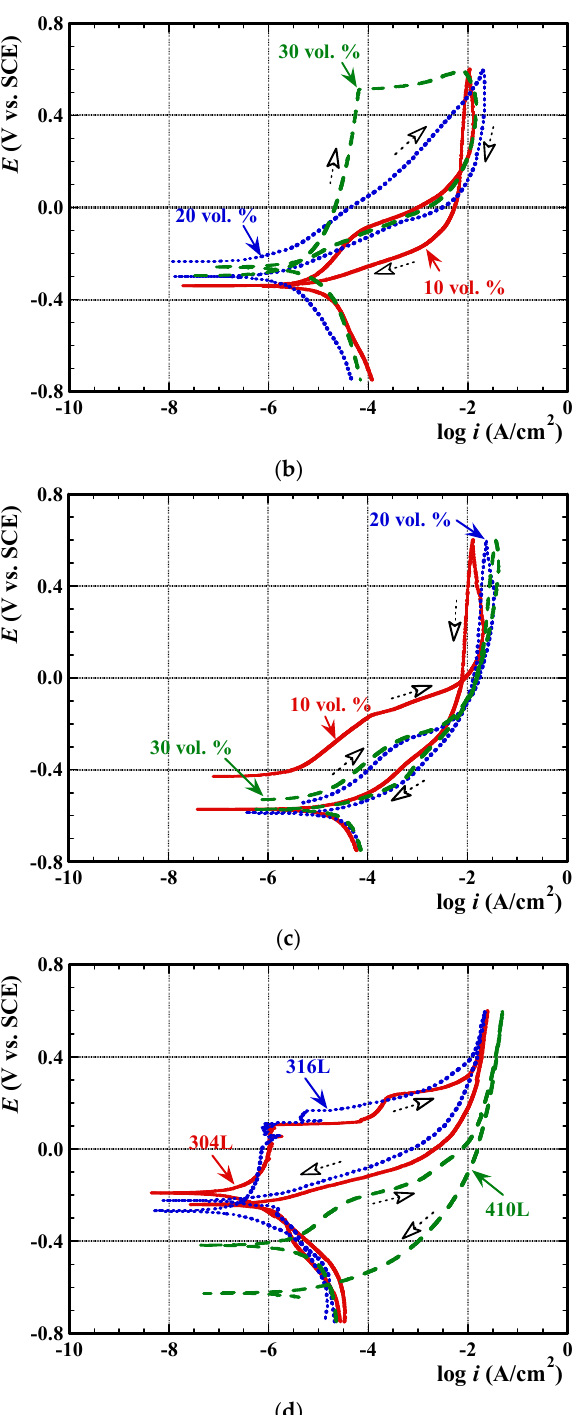
Figure 5. Representative cyclic polarisation curves, demonstrating the effects of binder content for each of the TiC–stainless steel cermets, together with comparison of the “pure” stainless steels: ( a ) TiC-304 L; ( b ) TiC-316 L; ( c ) TiC-410 L; and ( d ) the single phase metallic stainless steel. Note that the open arrows highlight the hysteresis loop directions for each figure (in terms of increasing test time).